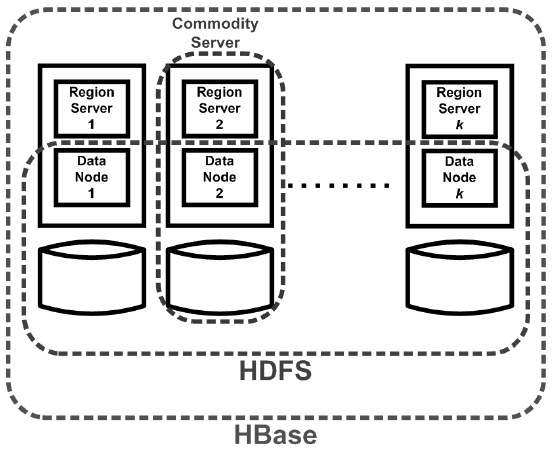
Figure 1. System model